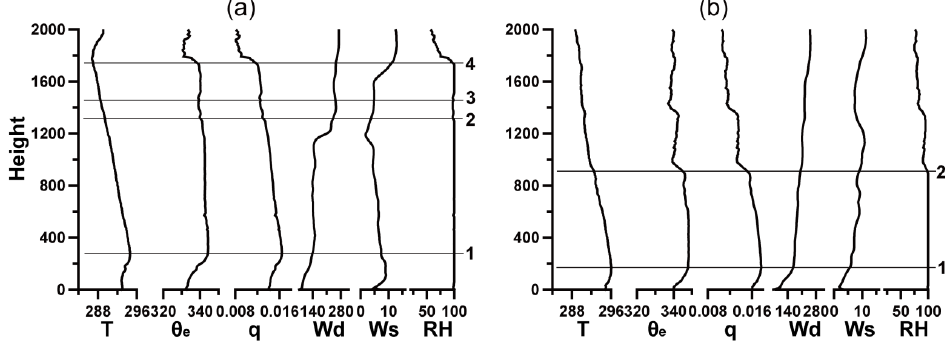
Figure 10. Boundary-layer structure at the time of the highest fog top of each fog case. ( a ) 0500 LST 11 March 2017 of case 1. ( b ) 0200 LST 31 March 2017 of case 2. Horizontal lines: 1 = height of the thermal-turbulence interface (determined as ∂θ e ∂ z = 0 ); 2 = top of the fog (determined as RH = 98%, the same as 3 and 4), 3 = cloud base, 4 = cloud top. Symbols: T = temperature (K), θ e = potential equivalent temperature (K), q = mixing ratio (kg kg − 1 ), Wd = wind direction ( ), Ws = wind speed (m s − 1 ), RH = relative humidity (%), and height = AGL (m).